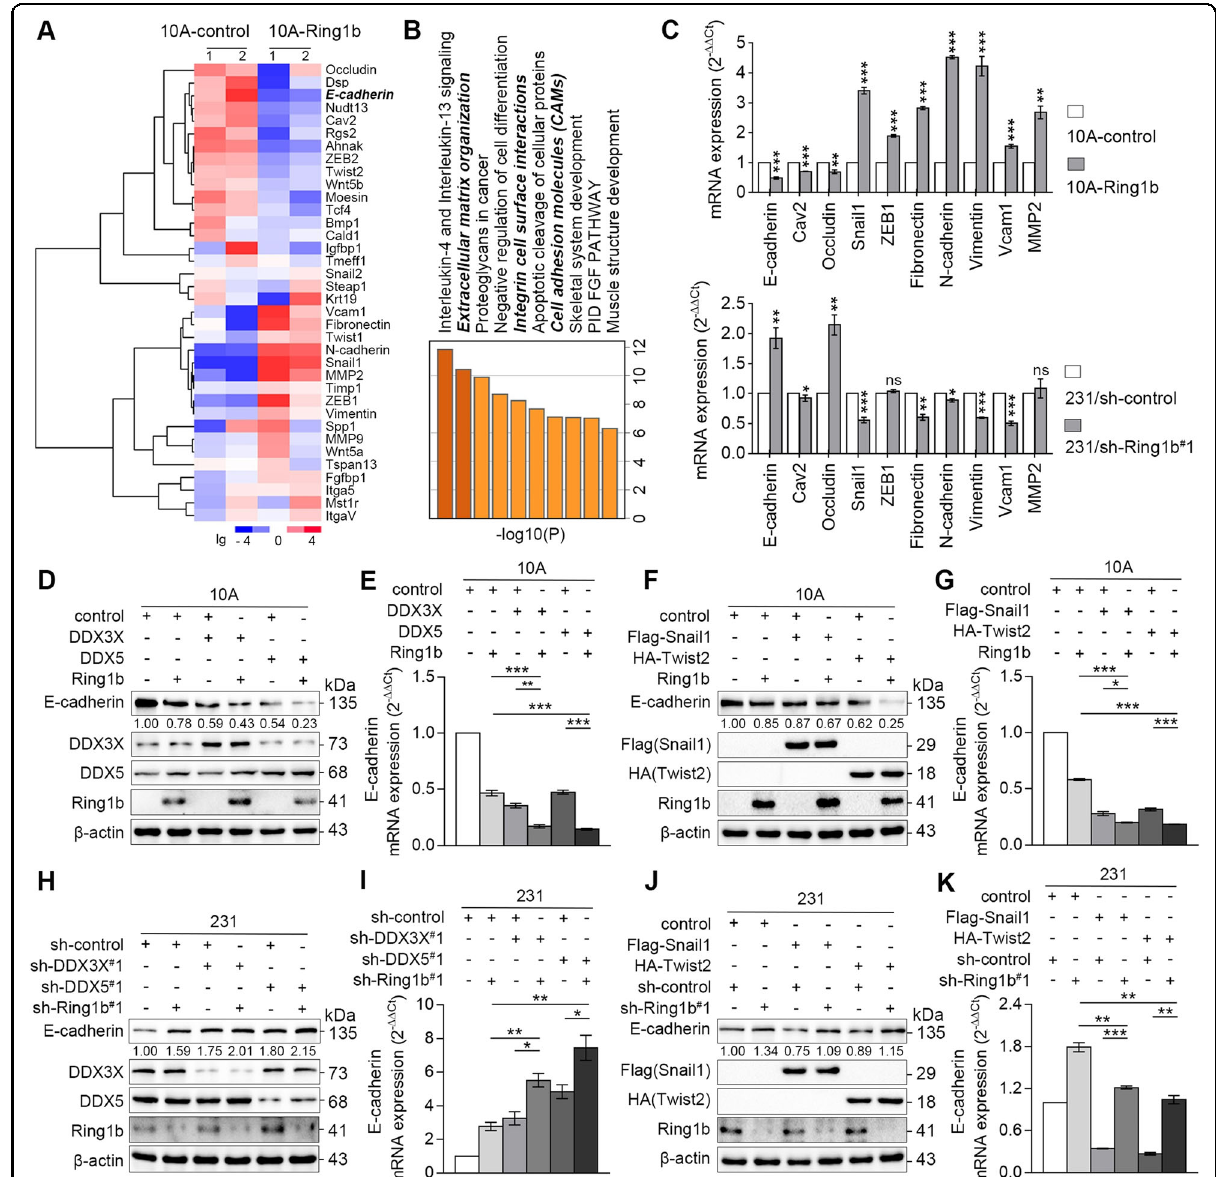
Fig. 3 Ring1b cooperates with DDXs or EMT TFs to strengthen the inhibition of E-cadherin. Proteins as indicated were stably overexpressed or knocked down in cells using lentivirus. A Clustering analysis of EMT-related genes ’ expression in fl uenced by Ring1b. Total RNAs isolated from 10A-control and 10A-Ring1b cells were analyzed by qRT-PCR. B Gene Ontology (GO) term analysis of EMT-related genes in fl uenced by Ring1b. C Effect of Ring1b on epithelial and epithelial genes expression. Total RNAs isolated from 10A and 231 cells were analyzed by qRT-PCR. D – K Effect of Ring1b complexes on E-cadherin expression in 10A and 231 cells. Total protein and RNAs isolated from cells were analyzed for E-cadherin expression by western blot and qRT-PCR. Error bars represent the means±SEM. Unpaired t -test is performed to indicate a statistically signi fi cant difference. ns, P ≥ 0.05; * P <0.05; ** P <0.01; *** P